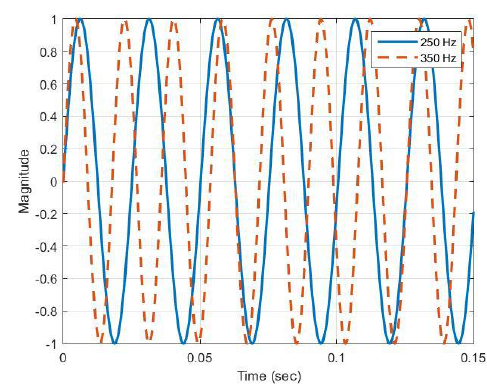
Figure A7. Sine wave frequencies 250, 350 Hz [2,4].